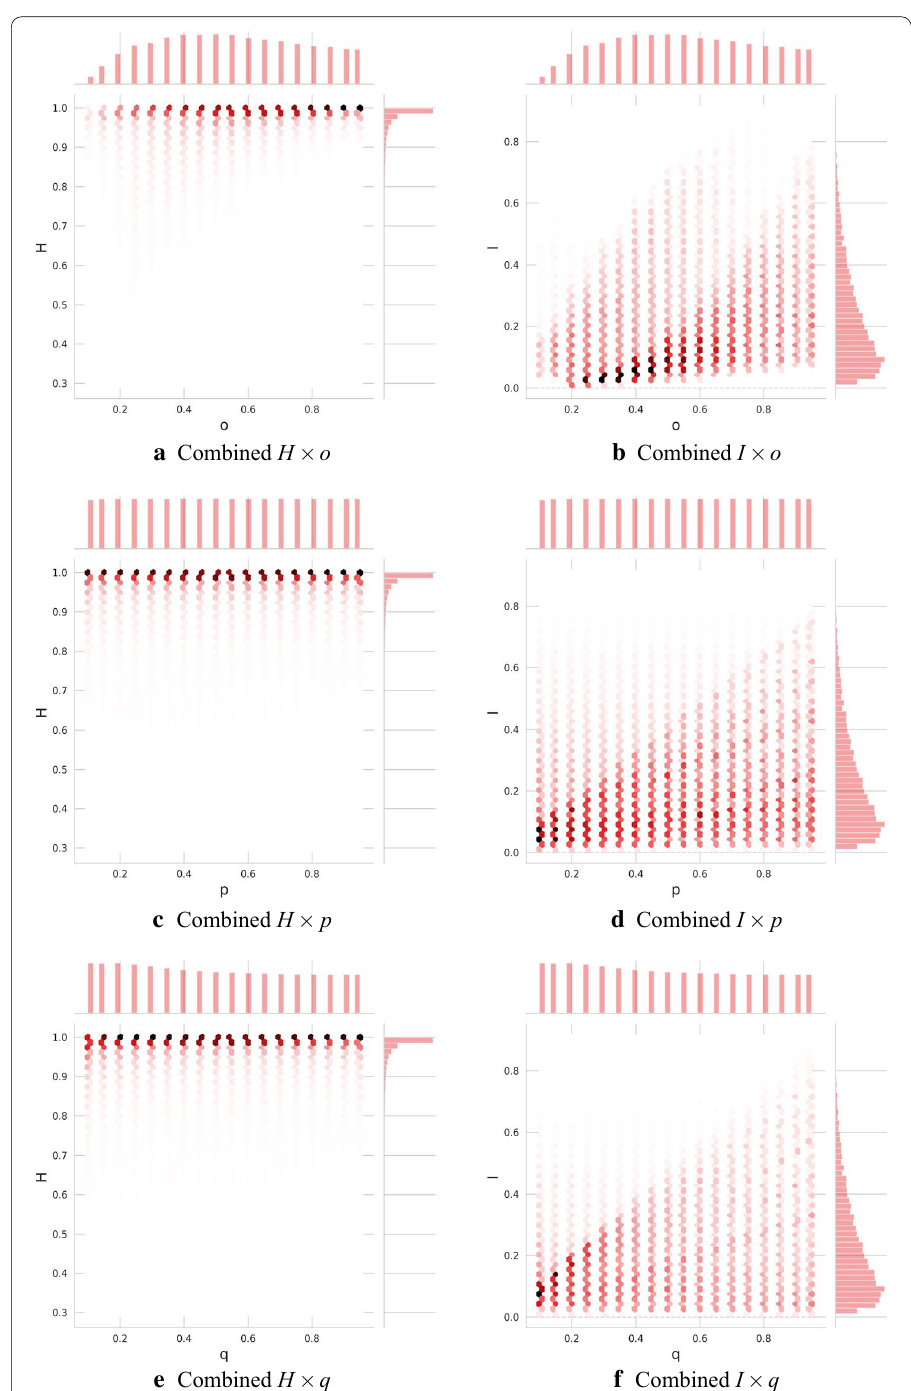
Fig. 24 Dependency on the different probabilities o , p and q on the combined layers